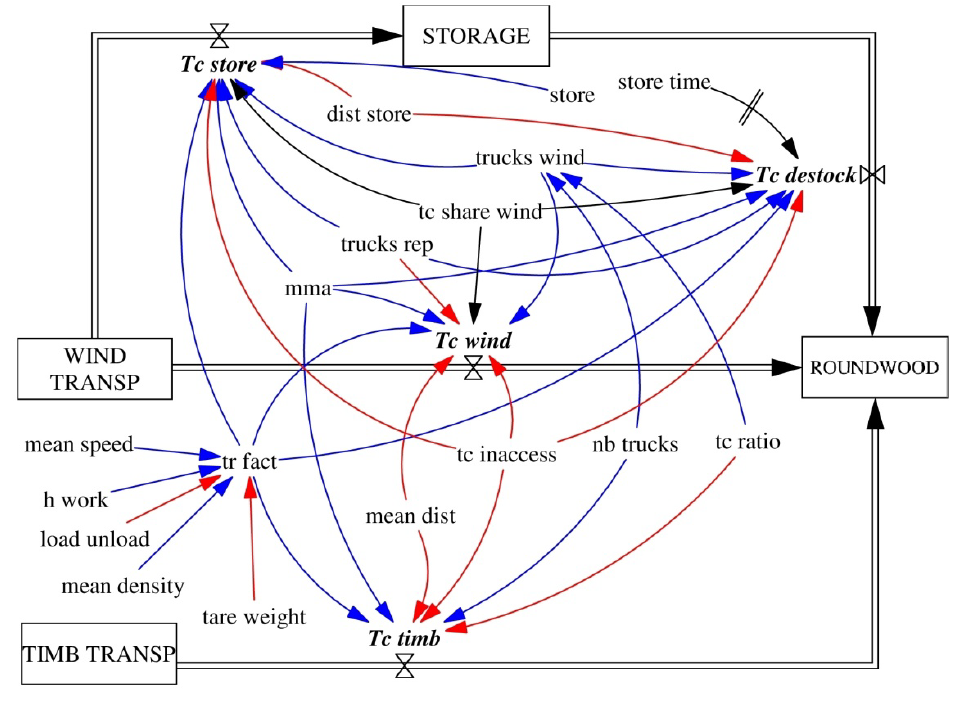
Figure 5. Transport